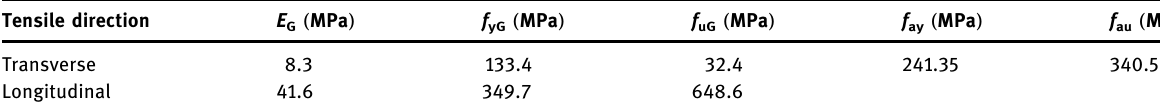
Table 2: Material properties of the GFRP tube Tensile direction